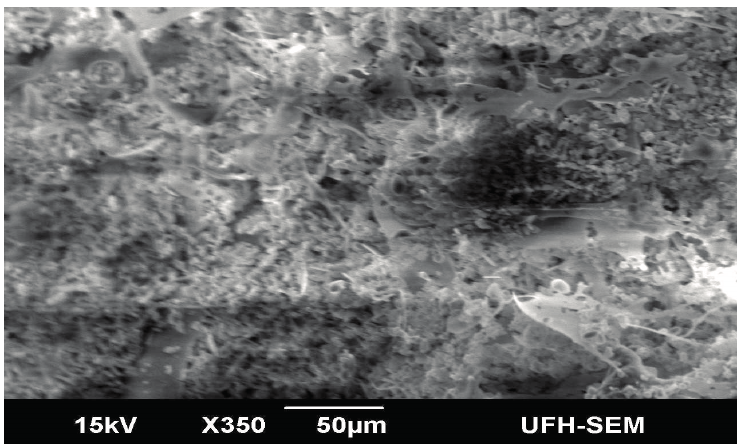
Figure 2. Scan electron micrographic image of the purified bioflocculant produced by the consortium of Brachybacterium sp. and Streptomyces